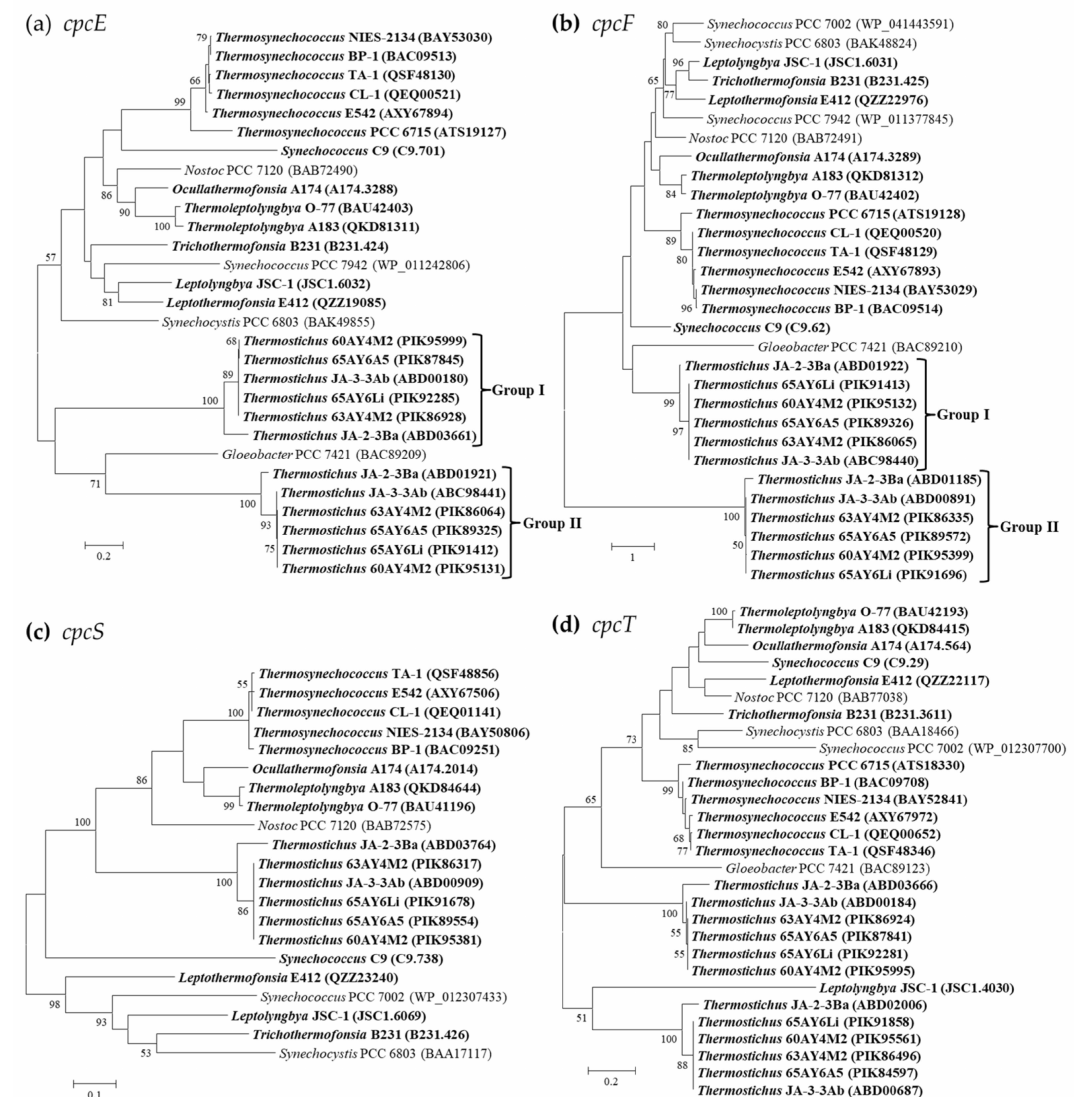
Figure 4. Phylogenetic inference of protein sequences encoding PC-associated phycobilin lyases. The thermophilic cyanobacteria surveyed in this study are indicated in bold. Only bootstrap values > 50% are indicated at nodes. ( a ) cpcE , ( b ) cpcF , ( c ) cpcS , ( d ) cpcT